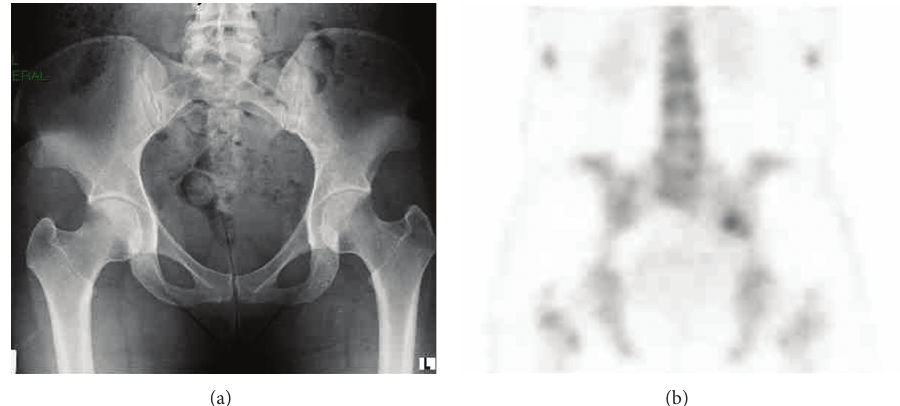
(a) (b) Figure 2: Imaging of the patient at 18 months after surgery: (a) pelvic X-ray shows mild narrowing of the left hip joint and (b) Tc-99m bone scan shows mild uptake at the left sacroiliac joint.